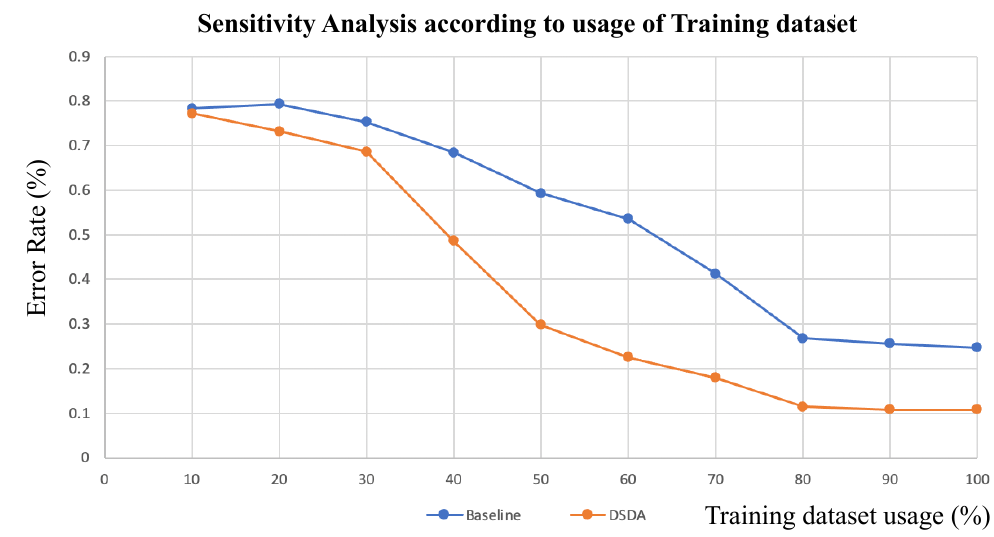
Figure 9. Sensitivity analysis of model performances according to the training dataset usage. The blue curve shows baseline [10], and the orange curve shows the proposed